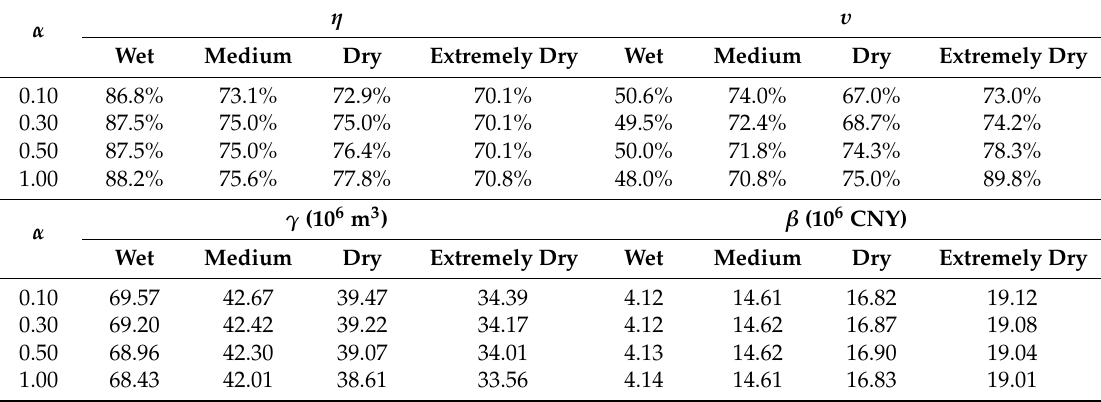
Table 3. Simulated statistics of indices under different hedging strategies and hydrological